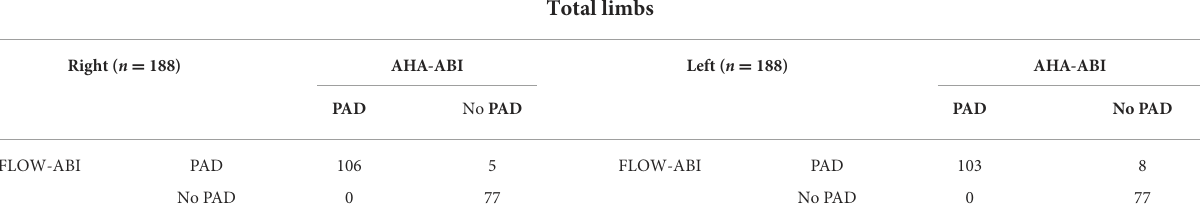
TABLE 3 Contingency tables between AHA-ABI and